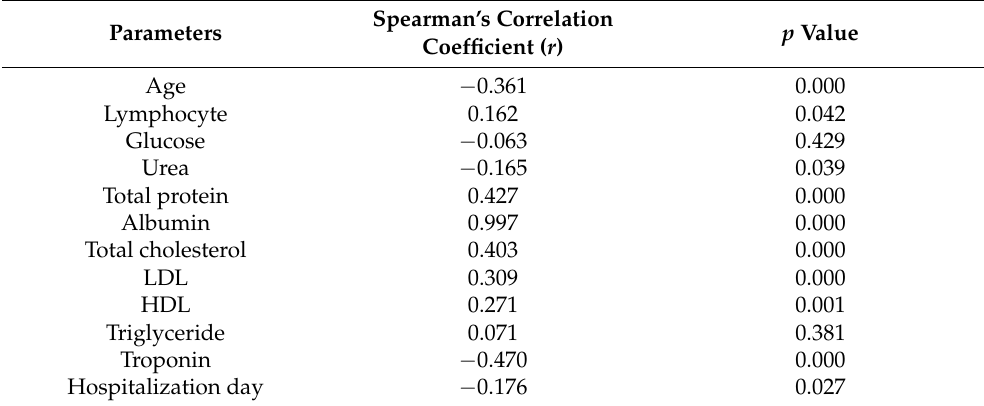
Table 3. Correlation analysis between PNI and clinical parameters in patients with acute is- chemic stroke.